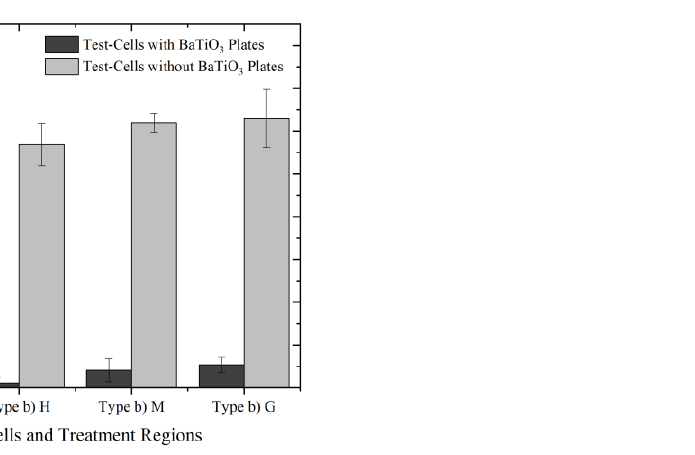
Figure 6. Effects of PEF treatment on the sterile rate of yeast using different types of chambers. Error bars show standard deviation (n = 3). Table 1. Statistical analysis of the experimental results of yeast sterilization (%).